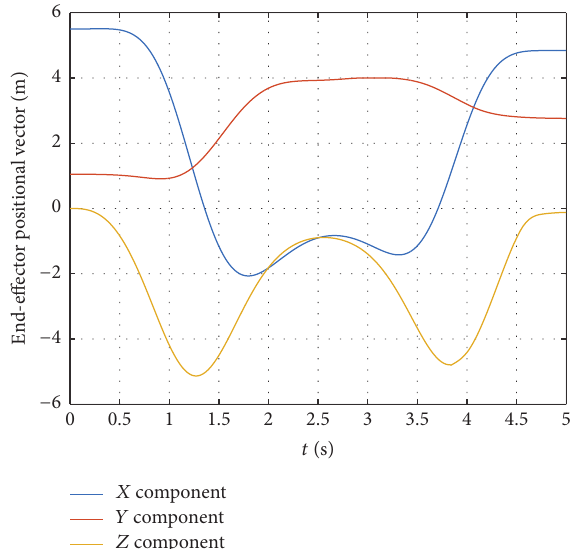
Figure 10: Positional curves of the end-effector in inertial reference frame.